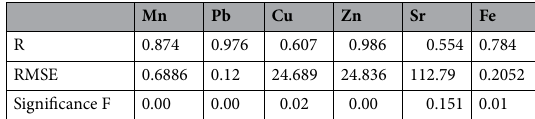
Table 5. Performance indicators of metal regression